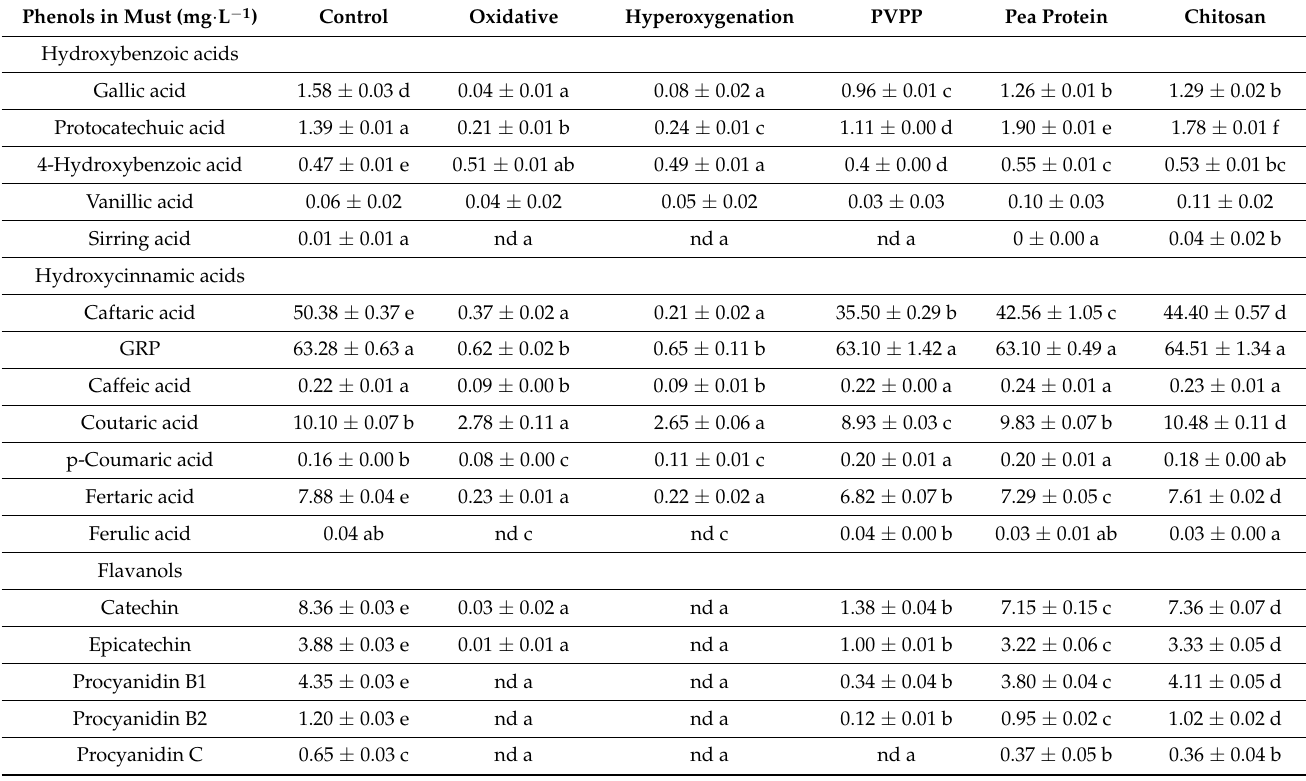
Table 2. Mean value of concentration of selected phenolic compounds in musts (mg · L − 1